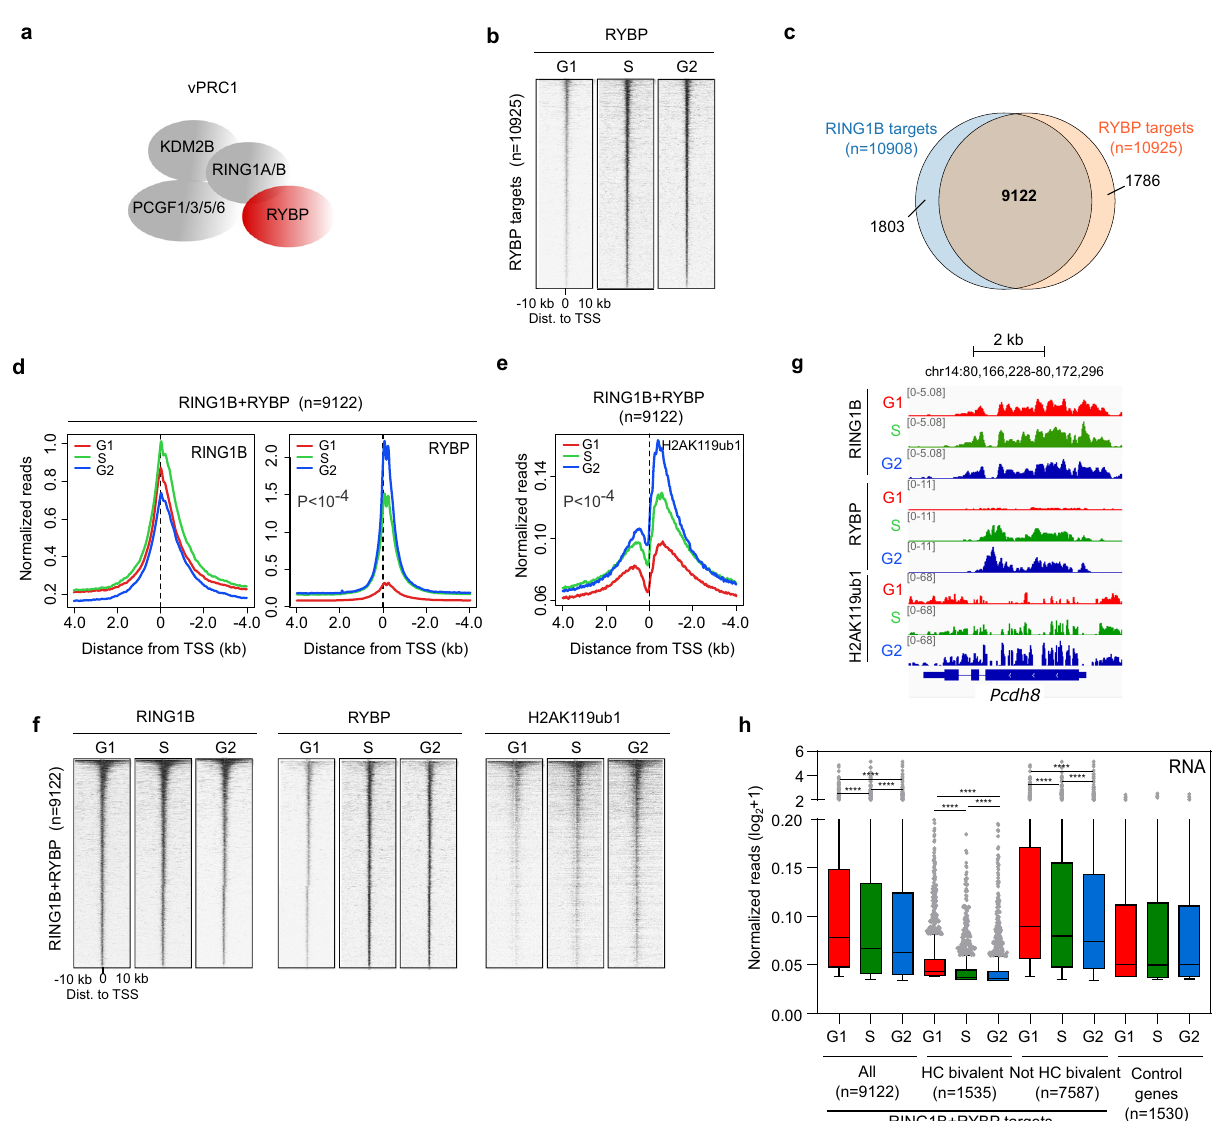
Fig.2|IncreasedrecruitmentofRYBPtotargetgenesduringSandG2phasesis associated with accumulation of H2AK119ub1 and enhanced transcriptional repression. a Scheme highlighting RYBP (red) in vPRC1 complexes in mESCs. b Heatmaps of normalized RYBP ChIP-seq reads around the TSS (±10kb) of target promoters ( n =10,925) at different phases of the cell cycle. Genes are ranked according to the signal in G2 phase. c Venn diagram showing the overlap between RING1B (blue)and RYBP (orange)targetpromoters. d , e Average binding pro fi le of RING1B and RYBP ( d ) and H2AK119ub1 ( e ) around the TSS of promoters bound by RING1B and RYBP (identi fi ed in c ) in G1 (red), S (green), and G2 (blue) phases. P indicates one-way ANOVA test p -value. f Heatmaps of normalized RING1B, RYBP, and H2AK119ub1 ChIP-seq reads around the TSS (±10kb) of RING1B and RYBP